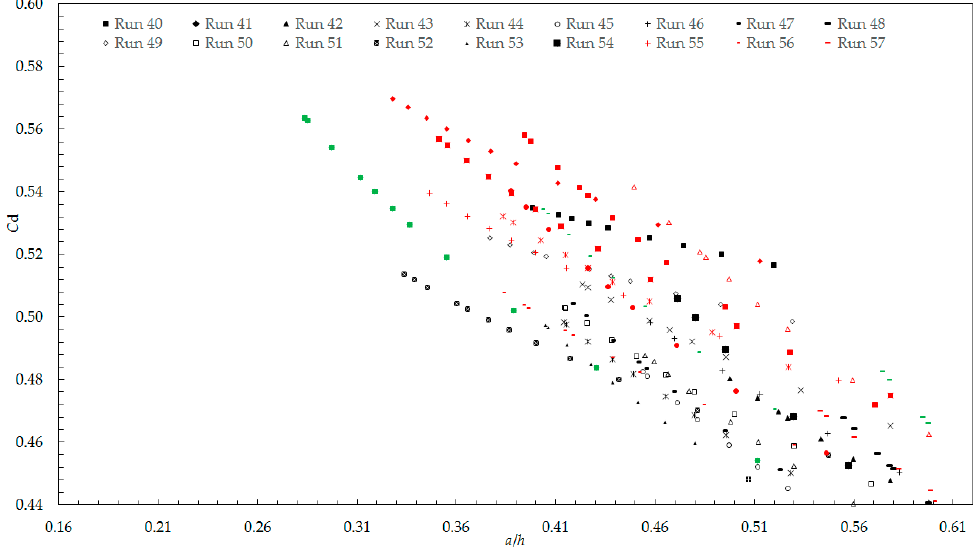
Figure 7. Discharge coefficients (C d ) versus a/h , Series 3.